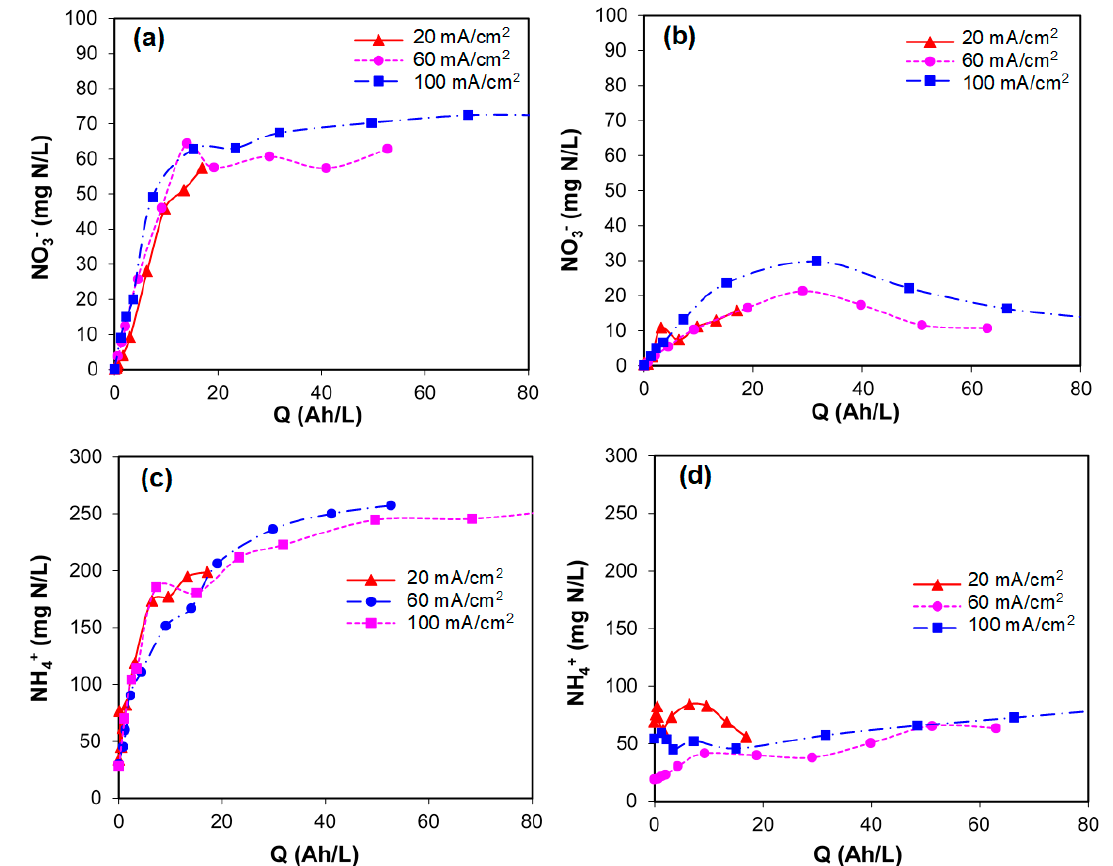
Figure 6. Changes in the concentration of nitrates ( a , b ) and ammonium ( c , d ) ions with the specific electric charge during electrolytic treatment of synthetic urine at pH = 5.5 and at room temperature (25 °C) using BDD ( a , c ) and DSA ( b , d ) anodes and a stainless steel cathode with a flow rate of 800 mL/min at different current densities: ( ▲ ) 20 mA/cm 2 , ( ● ) 60 mA/cm 2 , and ( ■ ) 100 mA/cm 2.